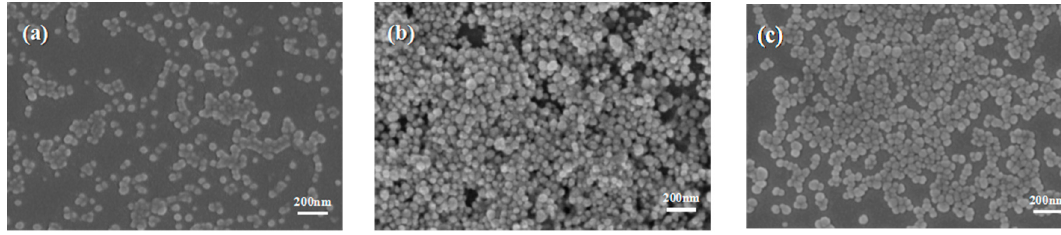
Figure 1. SEM images of Ag nanoparticles prepared under different temperatures: ( a ) 130 °C; ( b ) 140 °C; and ( c ) 150 °C.